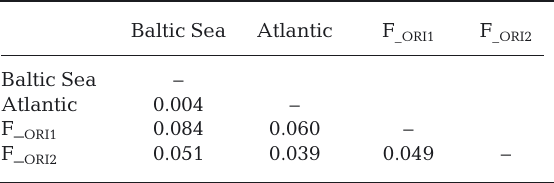
Table 2. Pairwise F ST matrix between pure wild and farmed groups of turbot based on 755 SNPs. All F ST values were significant after sequential Bonferroni correction (p < 0.005)